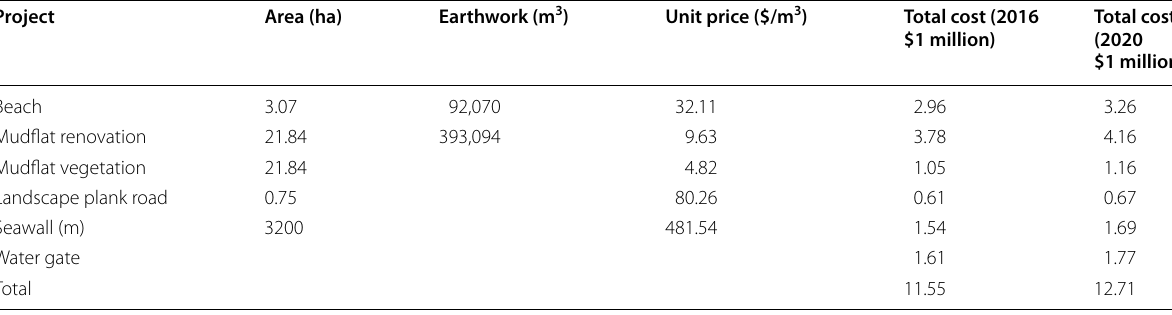
Table 4 Costs of the proposed ecological restoration project